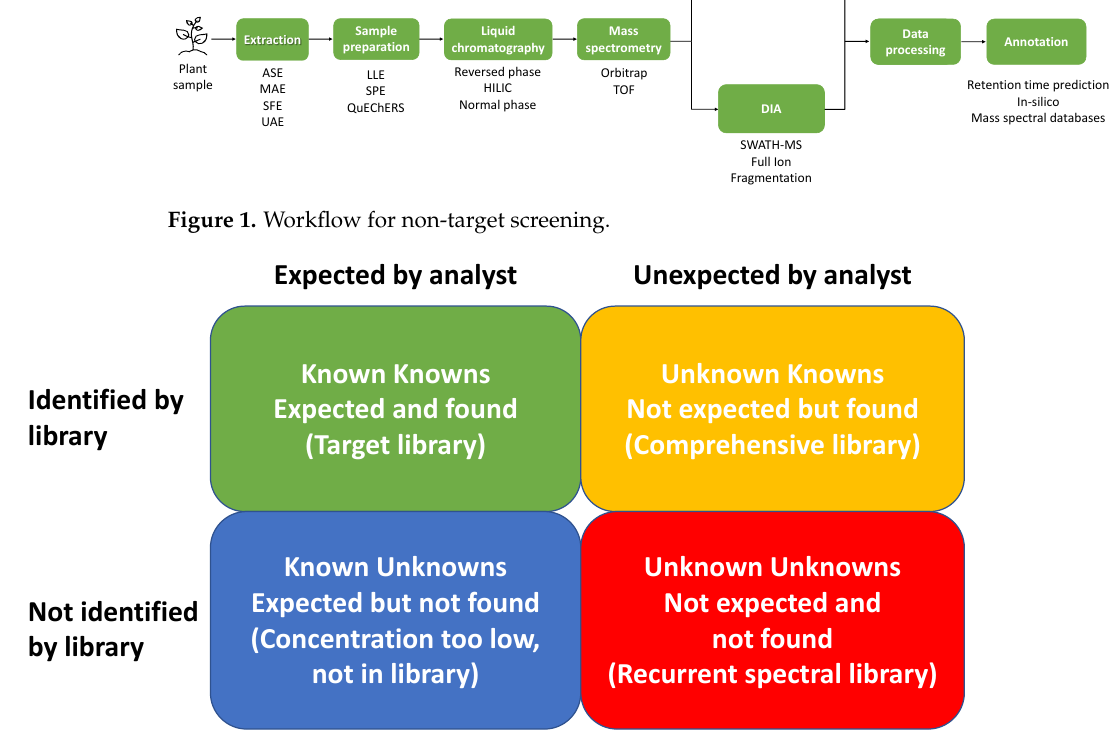
Figure 2. “Rumsfeld Quadrants” showing the intersection of yes/no answers for whether analysts expect a compound to be identified in the sample (prior probability) and whether it was identified in a library search [5]. Adapted with permission from [5].